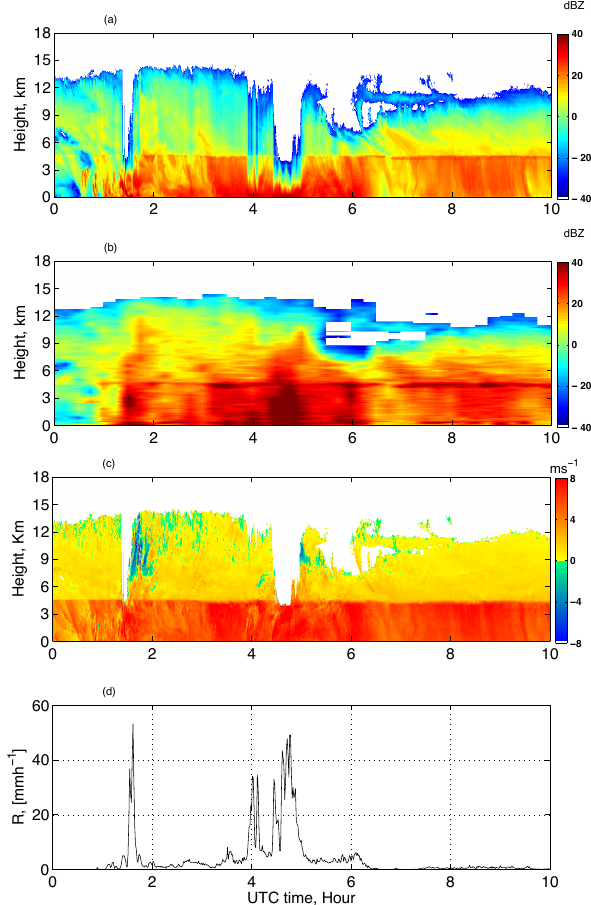
Figure 2. An example of time series of reflectivity from KAZR (a) , reflectivity from S-PolKa (b) , Doppler velocity from KAZR (c) , and surface rain rates from an optical rain-gauge (d) . Positive Doppler velocities in panel (c) represent downward